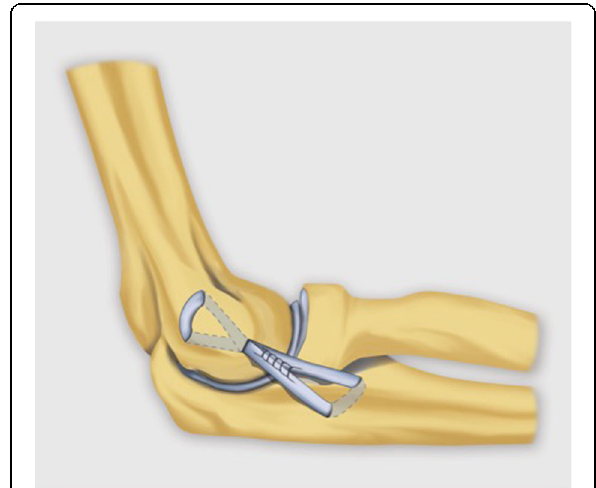
Fig. 38 Lateral view of the elbow demonstrating the open reconstruction technique for lateral ulnar collateral ligament